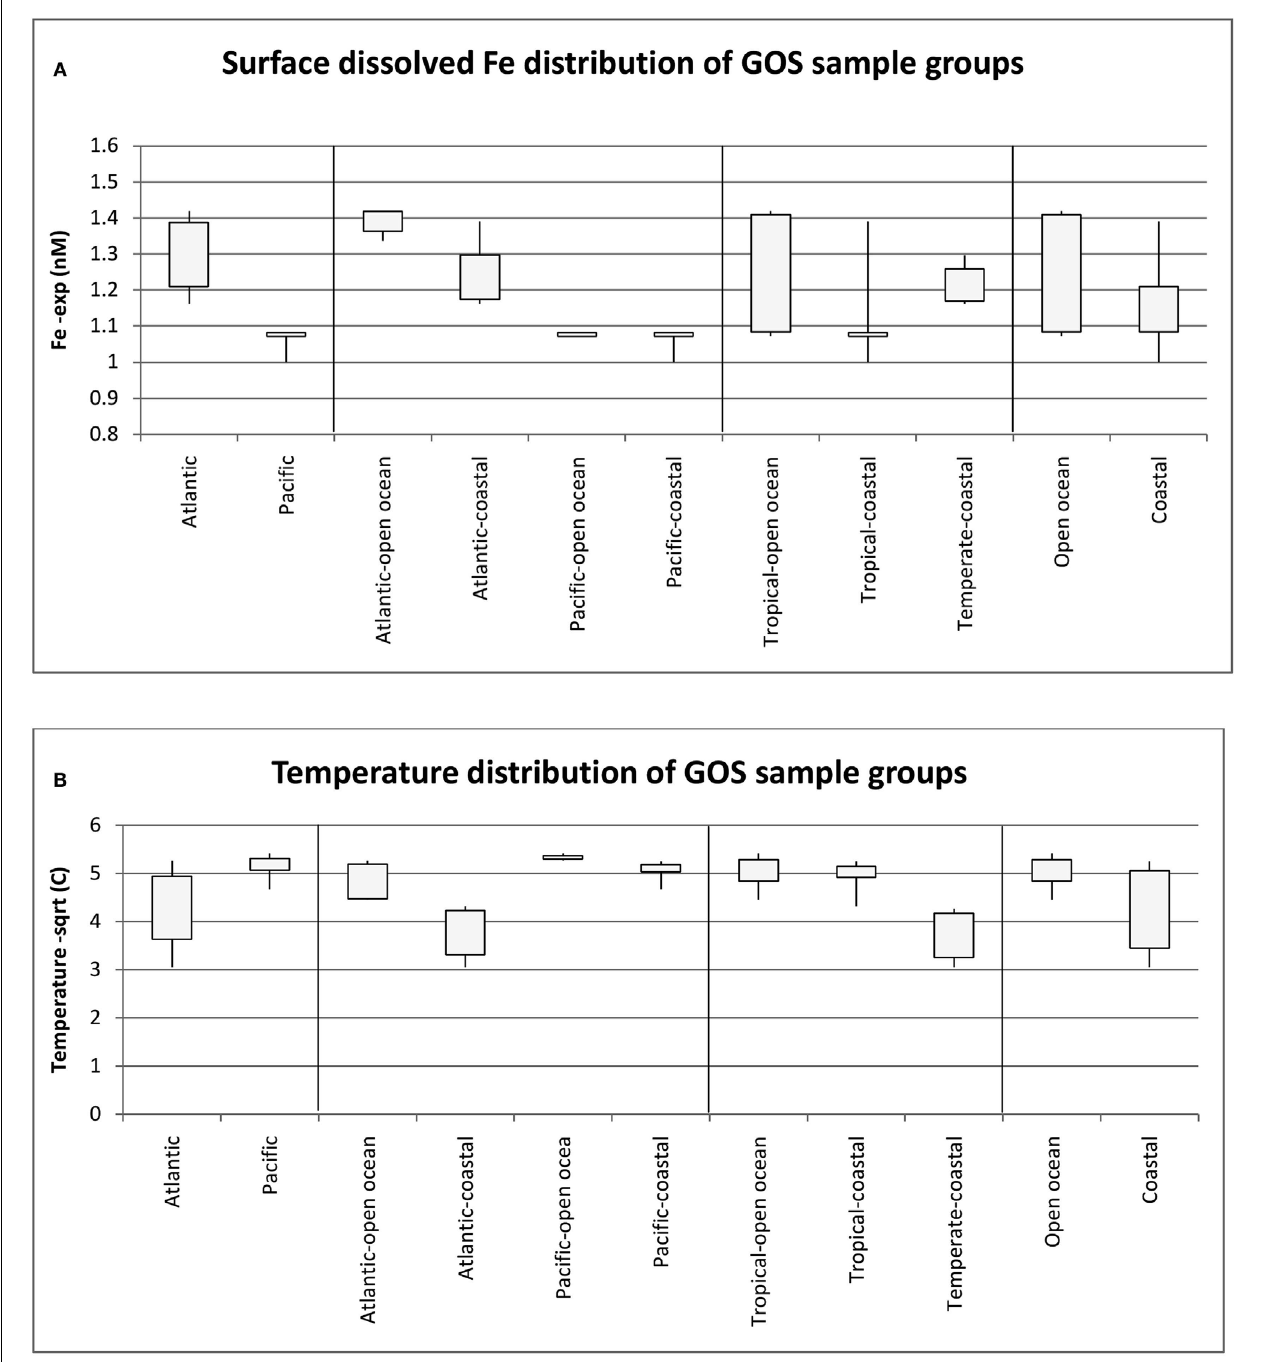
(12), Atlantic Open Ocean (9), Pacific Open Ocean (5), Pacific-Coastal (7), Tropical-Open Ocean (11),Tropical-Coastal (11),Temperate-Coastal (8), Open Ocean (14), Coastal